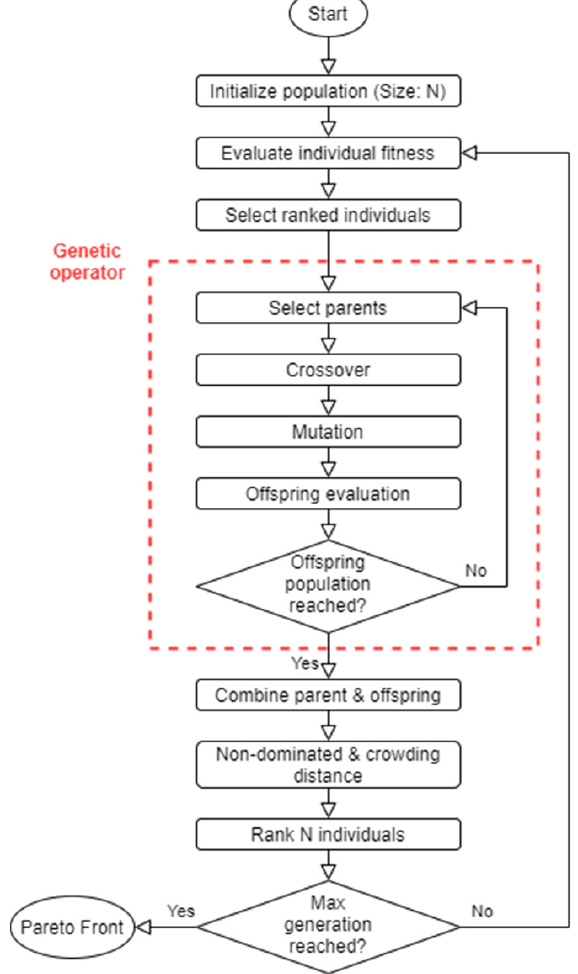
Figure 2. NSGA-II algorithm flowchart.